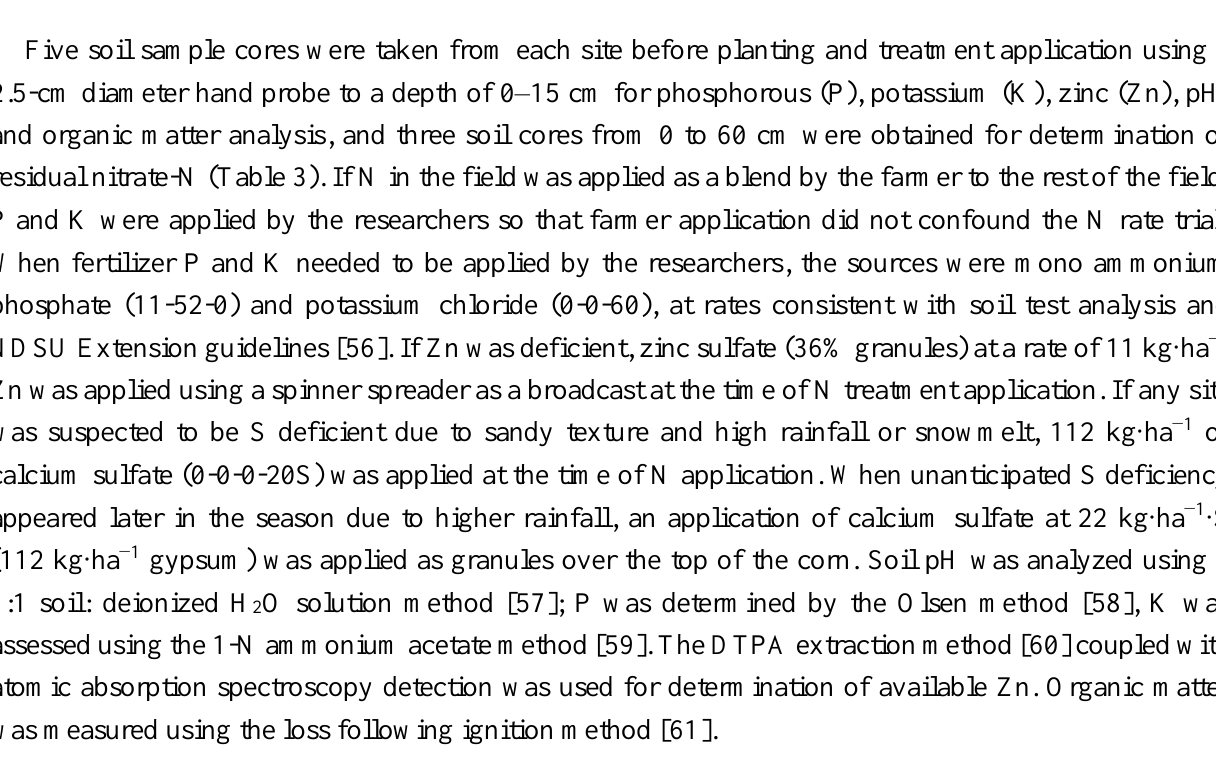
Table 3. Relevant soil analysis for experimental